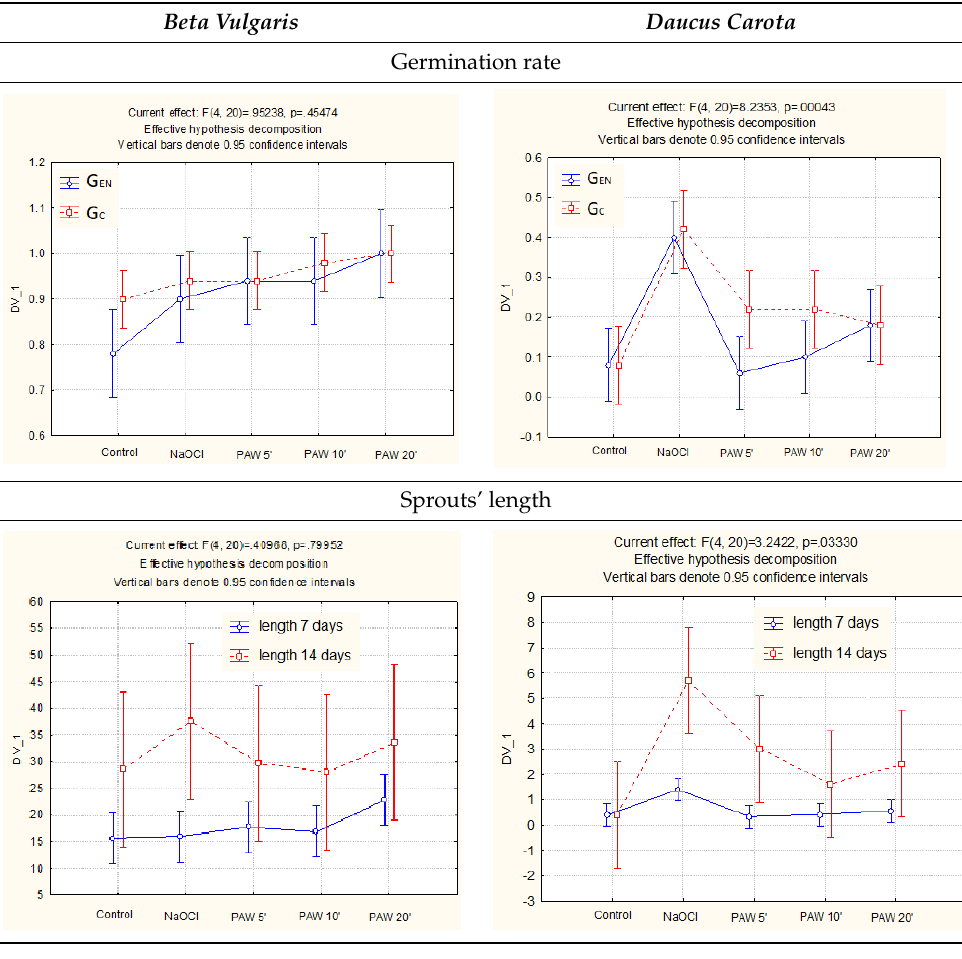
Table 4. Results of statistical analysis.